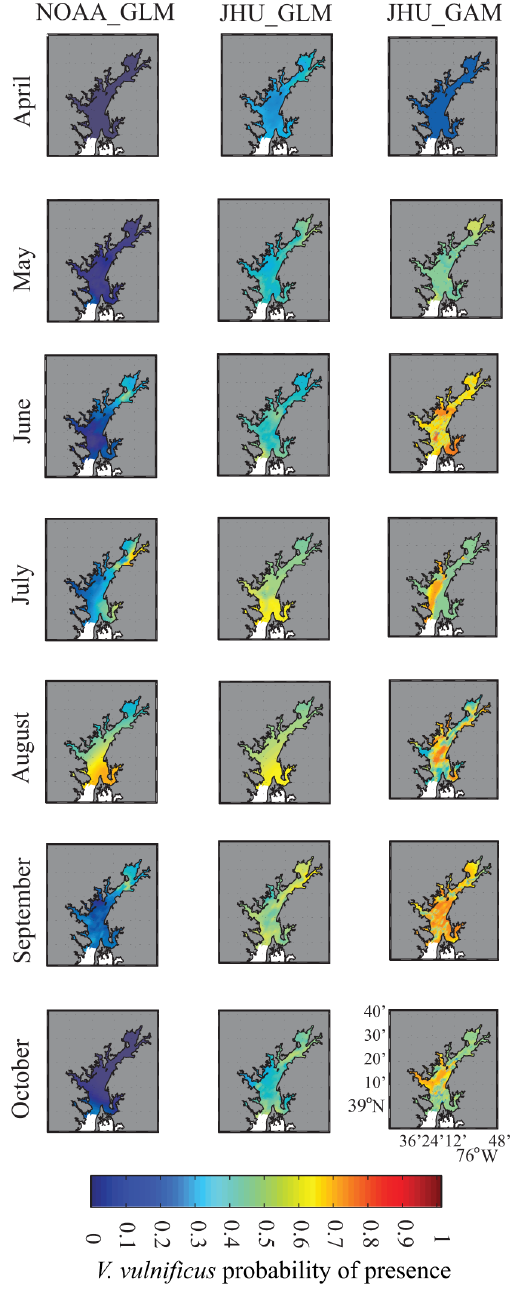
Figure 5. Upper Chesapeake Bay monthly V.vulnificus proba- bility hind-casts for April through October 2012, for NOAA GLM, JHU GLM, and JHU GAM methods.